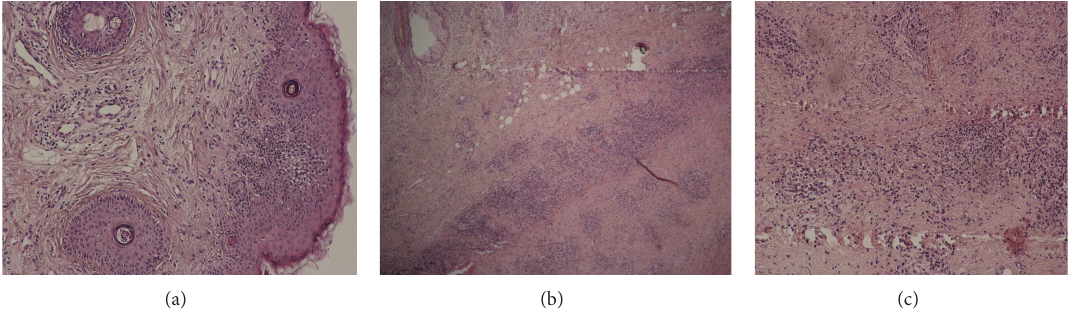
Figure 2: (a) The dermis contains a mild focal lymphohistiocytic infiltrate. H&E, × 100. (b) Degenerative and inflammatory changes affecting the marginal chondrocytes with loss of basophilia and poor alcian blue staining of the cartilaginous tissue. H&E, × 40. (c) The inflammatory cells infiltrate, including lymphocytes, plasma cells, and histiocytes, infiltrate the degenerative cartilage. H&E, ×